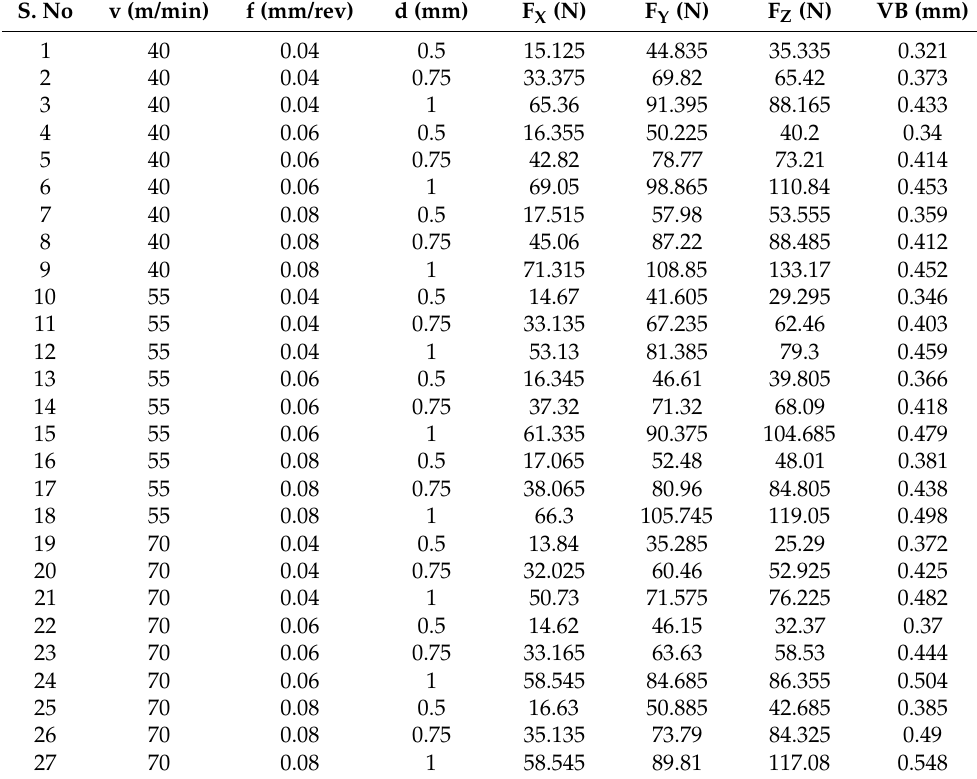
Table 3. Observation table obtained for cutting parameters speed, feed. and depth of